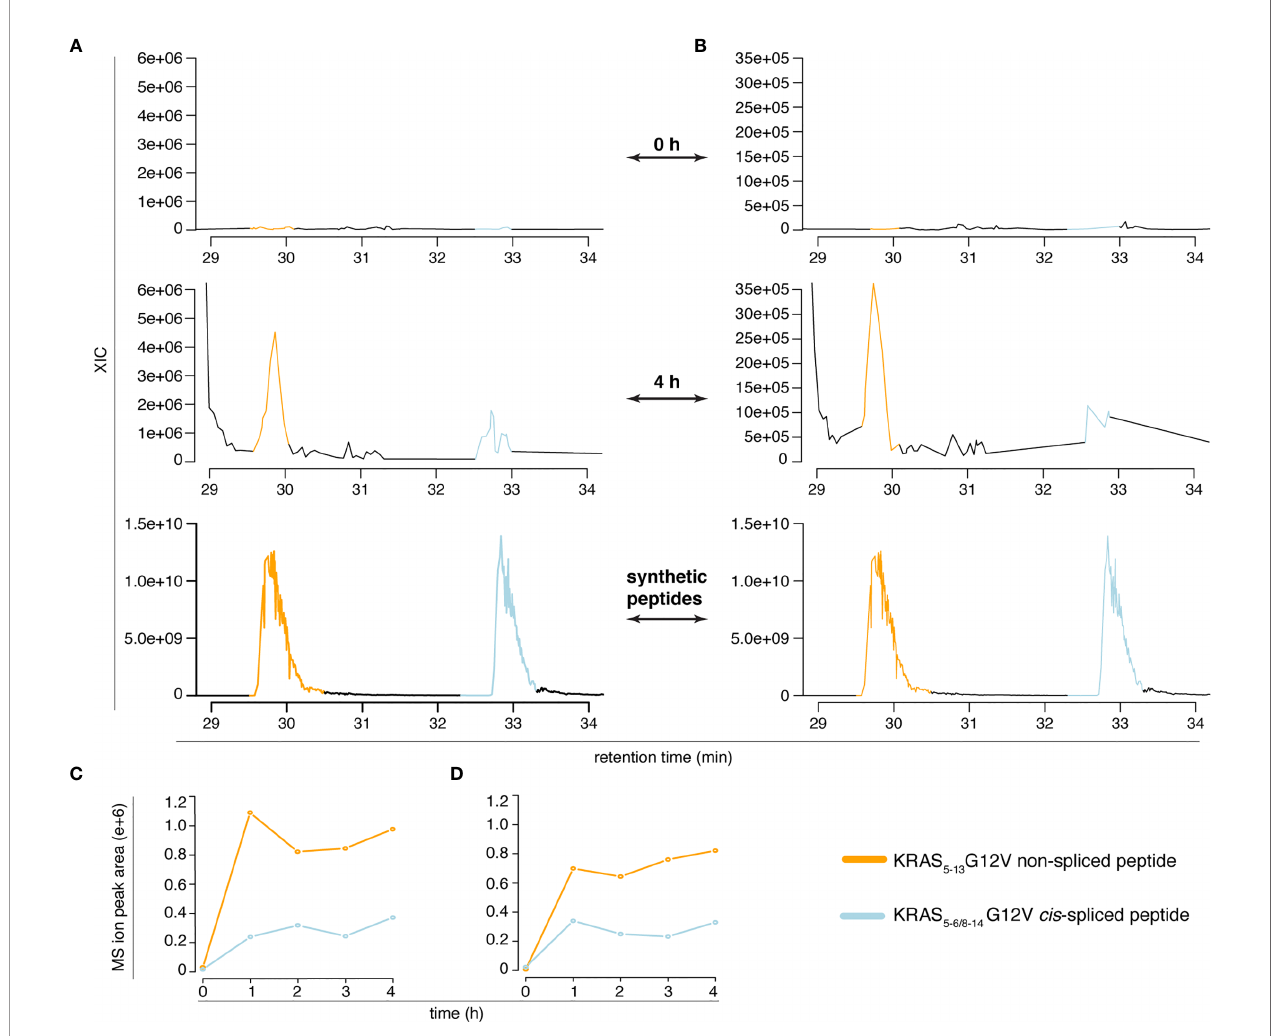
FIGURE 4 | Quanti fi cation of KRAS 5-6/8-14 G12V cis -spliced and KRAS 5-13 G12V non-spliced peptides in in vitro digestion kinetics. (A, B) MS extracted ion chromatograms of the target peptides in the in vitro digestion kinetics of the “ MF ” (A) and “ MG ” (B) series (0 h and 4 h) and of the mix of the two synthetic peptides. (C, D) Quanti fi cation of the MS ion peak area of the KRAS 5-6/8-14 G12V cis -spliced and KRAS 5-13 G12V non-spliced peptides in the in vitro digestion kinetics of the fi ed proteasomes using either HMDA ( “ MF ” “ MF ” (C) and “ MG ” (D) series. In (A – D) in vitro digestion kinetics of the synthetic polypeptide KRAS 2-35 G12V with puri series) or TMDA ( “ MG ” series) are shown. Samples have been measured through Q Exactive Orbitrap (one technical replicate each condition). The MS ion chromatograms correspond to the m/z = 421.275 –